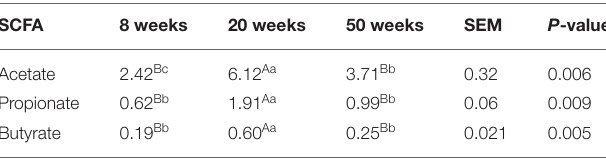
TABLE 4 | The concentration of short-chain fatty acids (SCFAs) (mmol/L) of chickens in different growth periods.